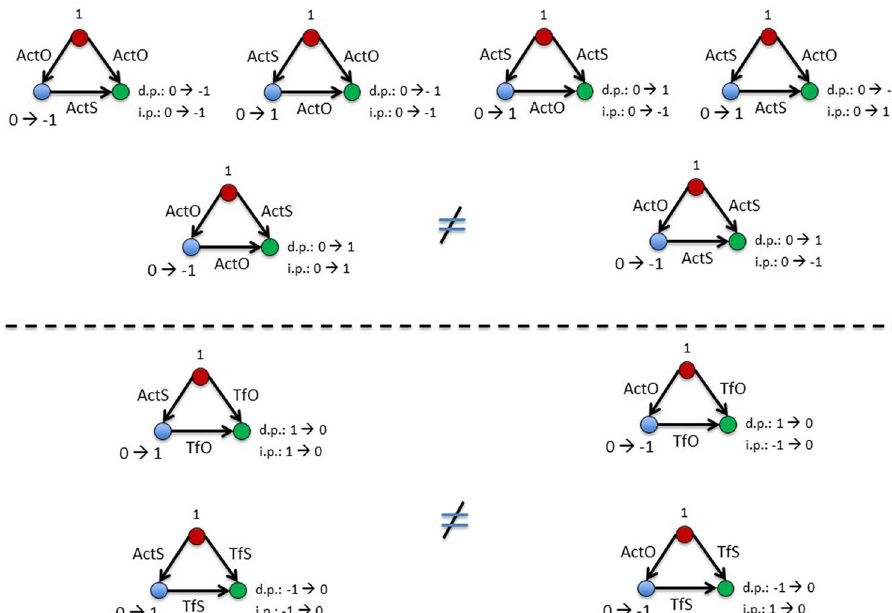
Figure 12. Dynamic of 1 st order subgraphs. Source, middle and sink nodes are in red, blue and green colour, respectively. From the source node two pathways can be characterized: an indirect pathway (i.p.) passing through the middle node, and a direct pathway (d.p.) going directly to the sink node. The time-dependent changes of the nodes state are reported for both indirect (i.p.) and direct pathways (d.p.). The triads in the left and right sections are not isophorms. For the difference between top and bottom panels see the text. Links can work in a synchronous or sequential way depending upon the relative state of the interacting